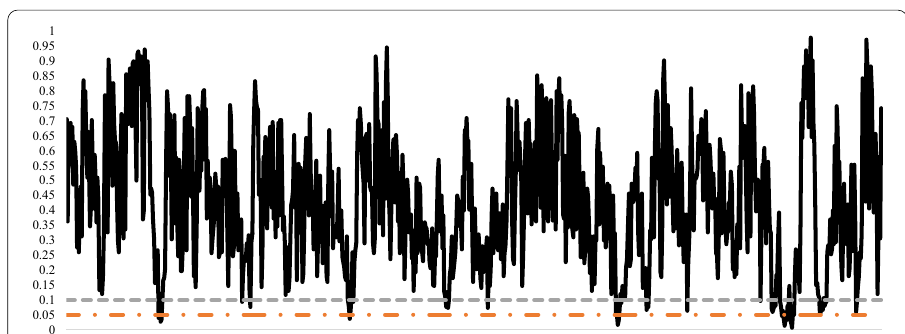
Fig. 32 The evolving p values of the GS test statistic checked for the WTI in 50-day window length